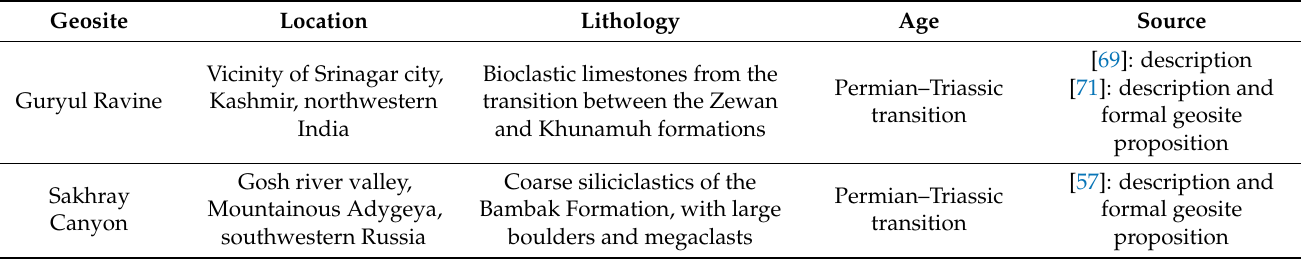
Table 2. Examples of geoheritage related to possible Triassic